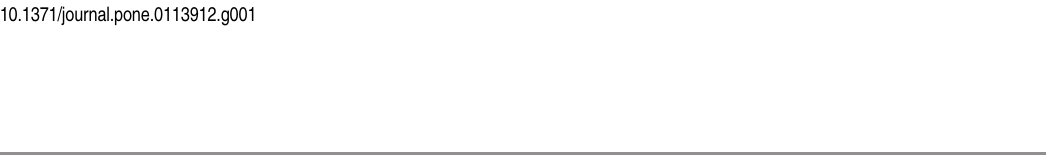
Figure 1. PRISMA flow diagram of study